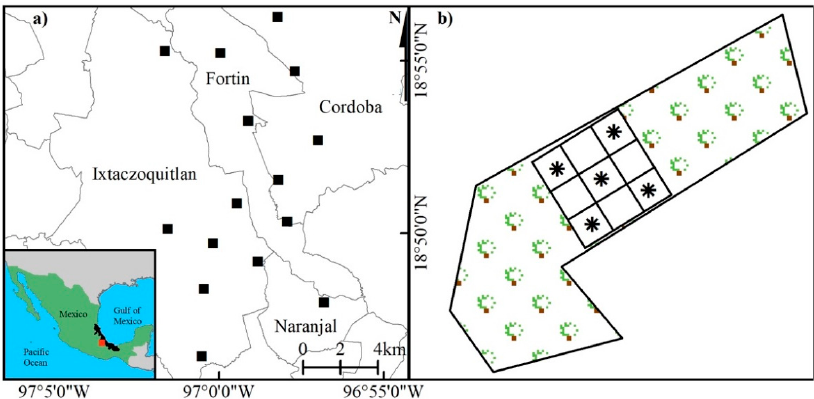
Figure 1. Location of the study area in central Veracruz, Mexico. ( a ) The location of the study area (red square) is indicated in the inset map along with the state of Veracruz (black polygon), and the location of Mexico (green polygon) between North and Central America (gray polygons). The black squares represent the 15 permanent sampling plots, and political division is shown as a solid gray line. ( b ) Sampling design: where a permanent sampling plot is represented with the five selected sampling units in an ornamental palm plantation.